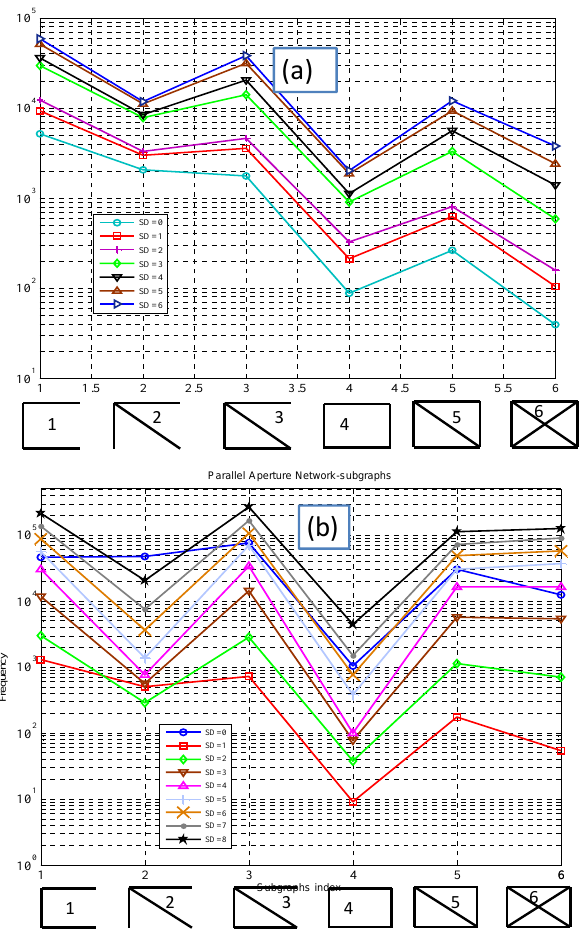
Figure 9. Evolution of 4-points sub-graphs for profiles in X and Y directions Fig. 9. Evolution of 4-points sub-graphs for profiles in X and Y though each shear slip (SD, mm): a) perpendicular profiles, b) Parallel profiles. directions though each shear slip (SD, mm): (a) perpendicular pro- files, (b) parallel